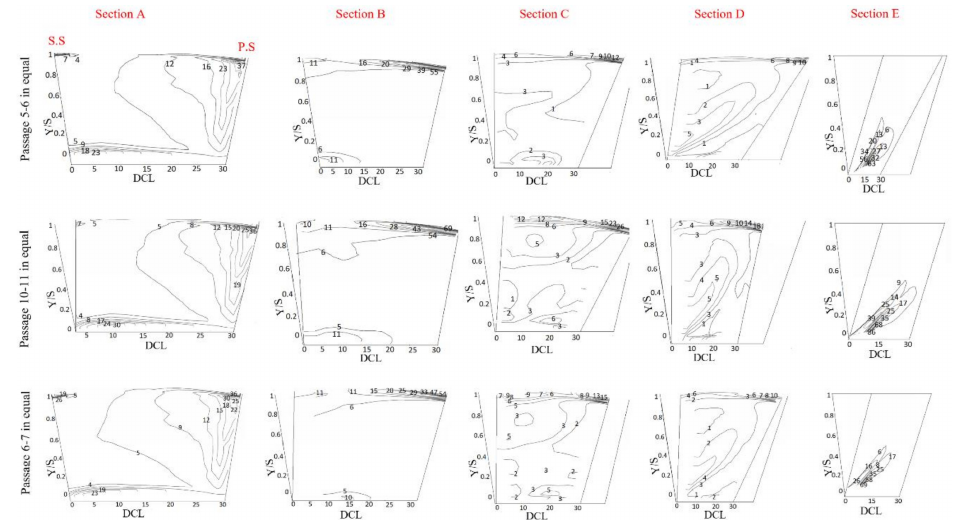
Figure 8. Vorticity contours at specified sections in blade passages 5–6, 10–11, and 6–7 of the equal case in spanwise location against the degree in circumferential location